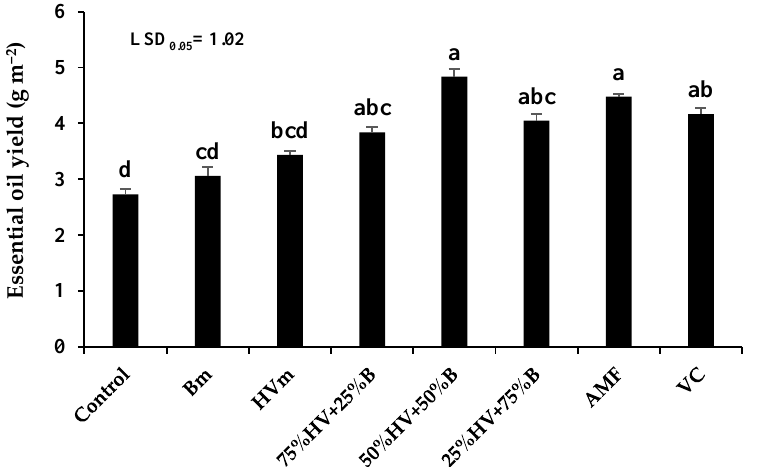
Figure 4. The essential oil yield of peppermint in different fertilizer sources. Bm (Barley monoculture); HVm (hairy vetch monoculture); 50%HV + 50%B, 75%HV + 25%B and 25%HV + 75%B (different intercrop ratios of hairy vetch/barley); AMF (arbuscular mycorrhizal fungi); VC (vermicompost). Same letters above the bars do not differ significantly ( p < 0.05) according to LSD test.